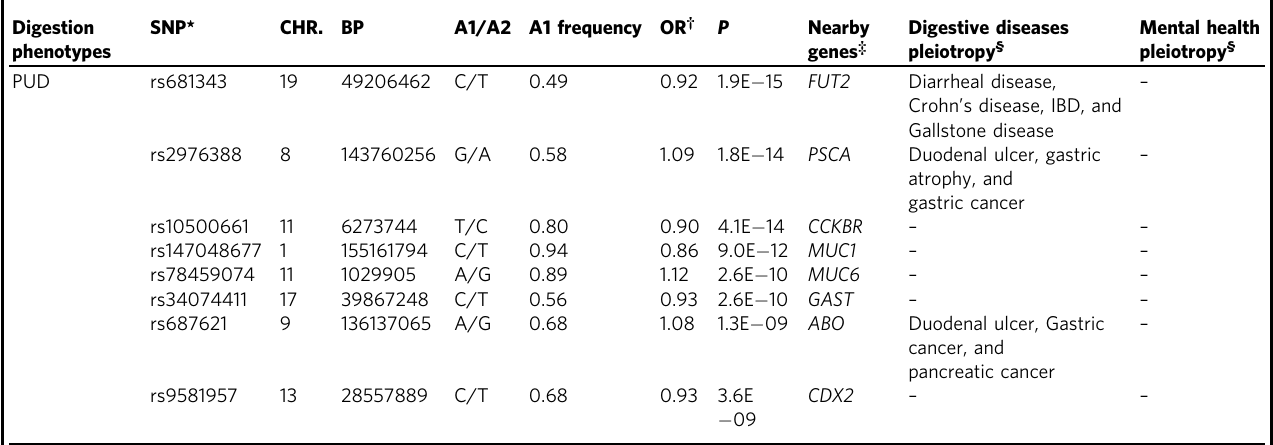
Table 2 Genome-wide signi fi cant SNPs associated with PUD in the UK Biobank. Digestion